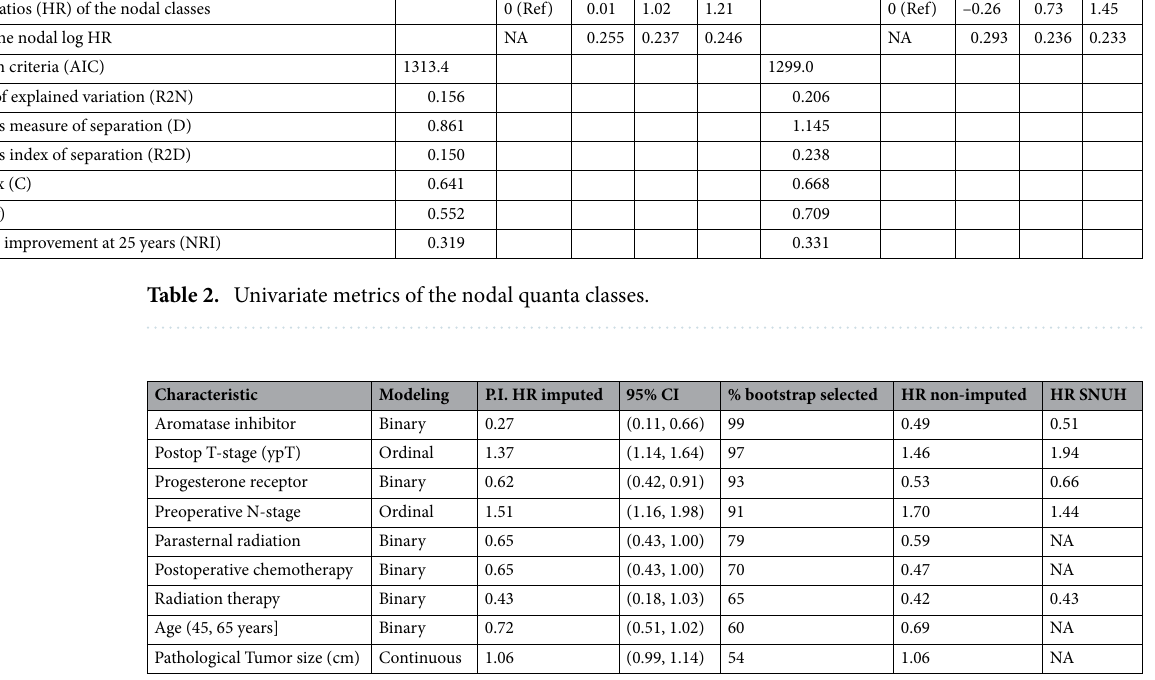
Table 3. Prognostic index (P.I.) survival model without nodal quanta. HR hazard ratio, SNUH Seoul National University Hospital, NA not